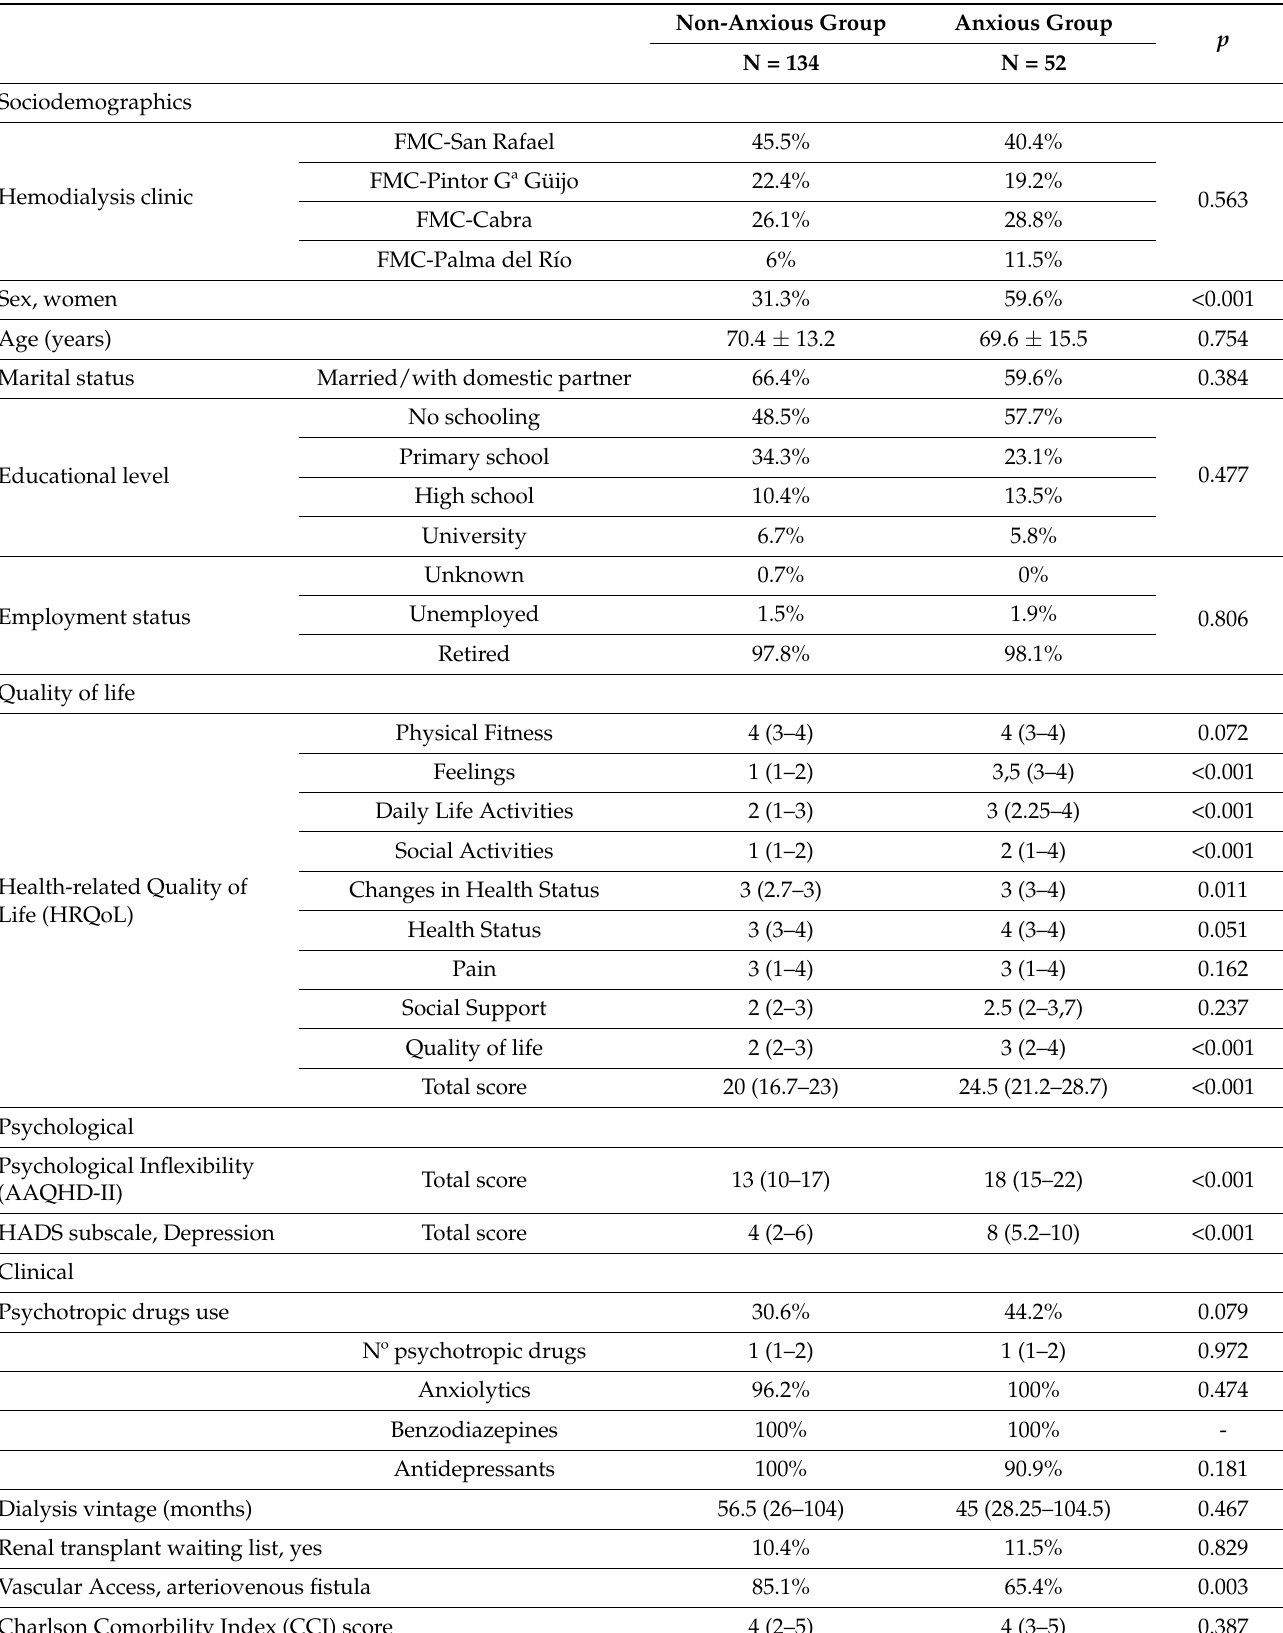
Table 2. Baseline characteristics of study population according to the anxious